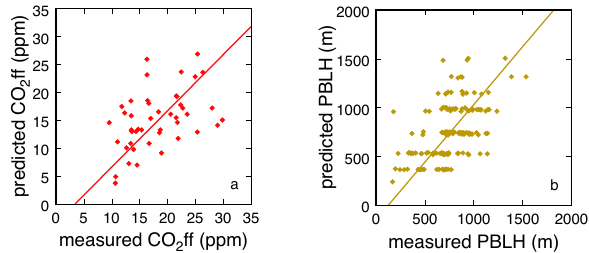
Fig. B3. Direct comparison of predicted versus measured (a) CO 2 ff and (b) PBLH, for 13:00–18:00. The regression curves, based on requiring that reduced χ 2 = 1, are as follows: CO 2 ff predicted = − 3.49 ( ± 3.21) + CO · 1.01 ( ± 0.19); RMSerror = 2 ff measured 5ppm; PBLH predicted = − 147 ( ± 78) + PBLH measured · 1.18 ( ± 0.10); RMSerror = 246